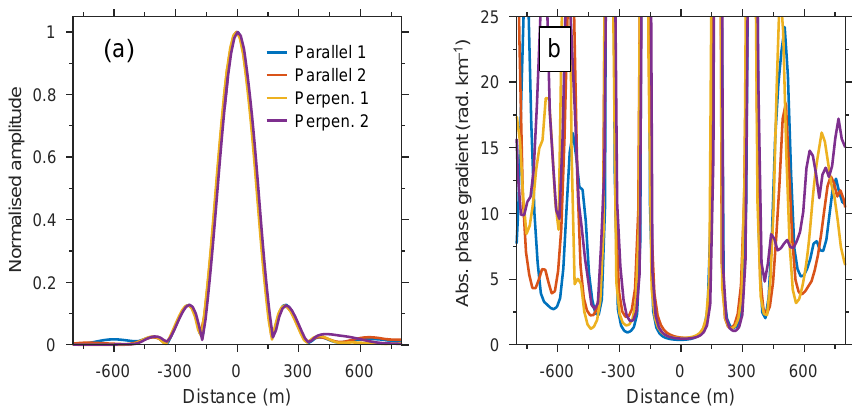
Figure 6. Impact of four wind turbines on weather radar I/Q data, recorded by Vara during conditions with wind direction from the southwest. Two turbines were located northeast of the radar, parallel to the wind direction. The other two turbines were located to the northwest, perpendicular to the wind direction. Panel (a) shows the average normalised amplitudes, and panel (b) shows the corresponding average absolute phase